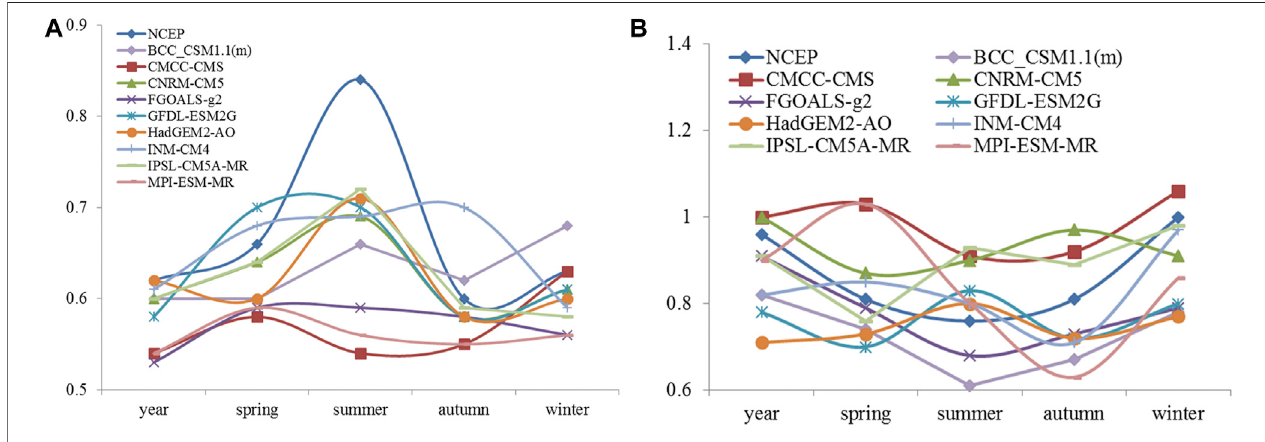
FIGURE 4 | The same as Figure 2 , but for the point of (175 ° W, 0 °